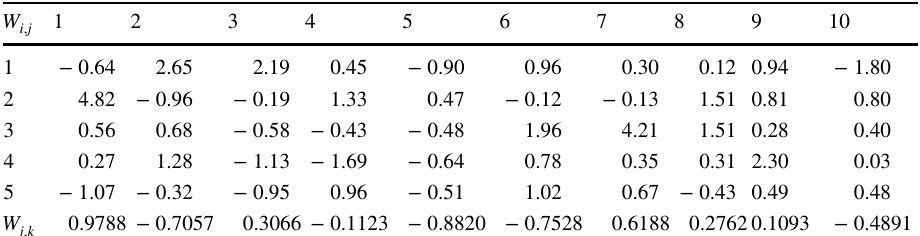
Table 5 Typical input–output data for ANN training for removal of cyanide and phenol from synthetic